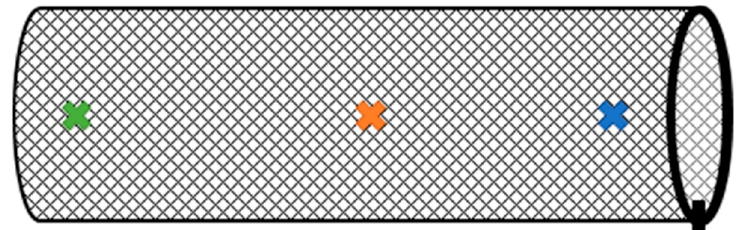
Figure 6. Distribution of the measuring points along the entire structure height.